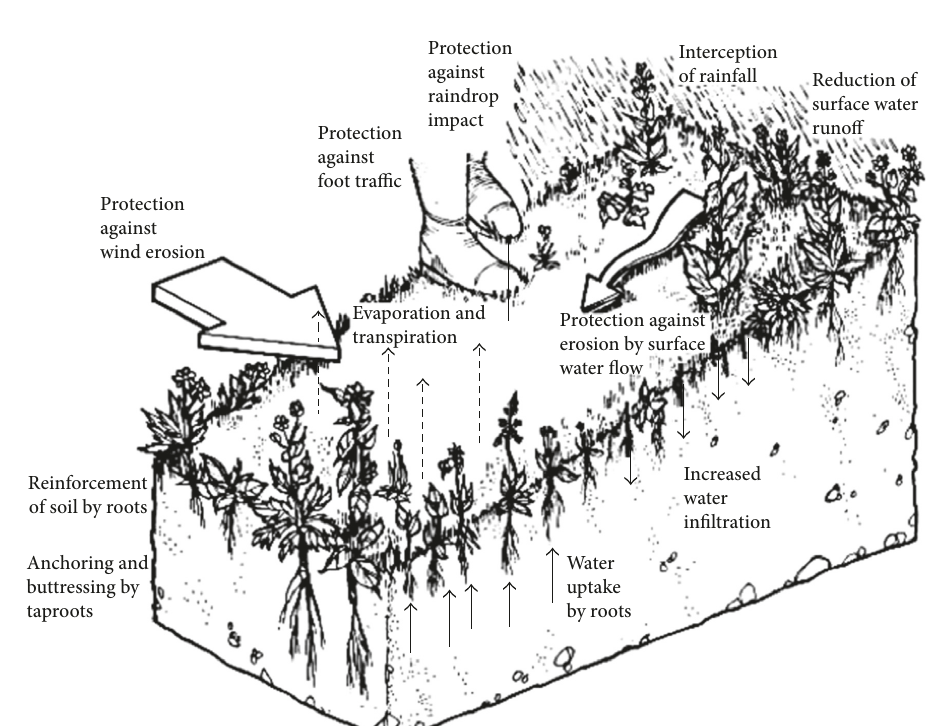
Figure 6: Influences of vegetation on the slope